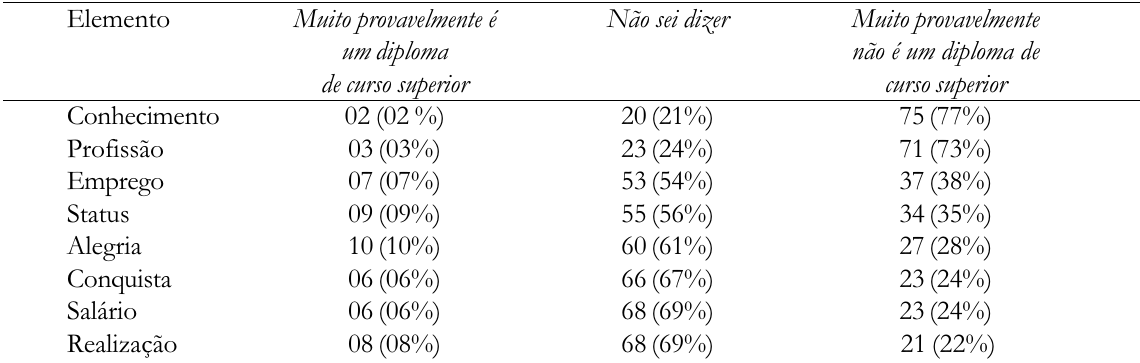
Teste de Centralidade, Objeto (cid:147)Diploma Superior(cid:148)